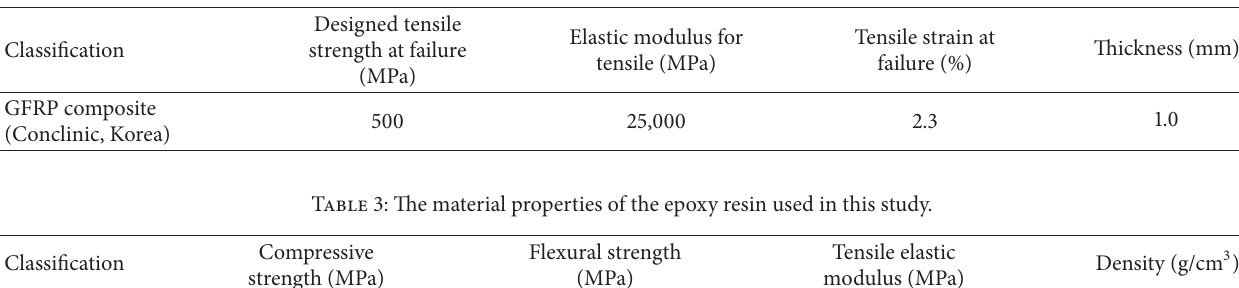
Table 2: Physical properties of the glass fiber composite used in this study.